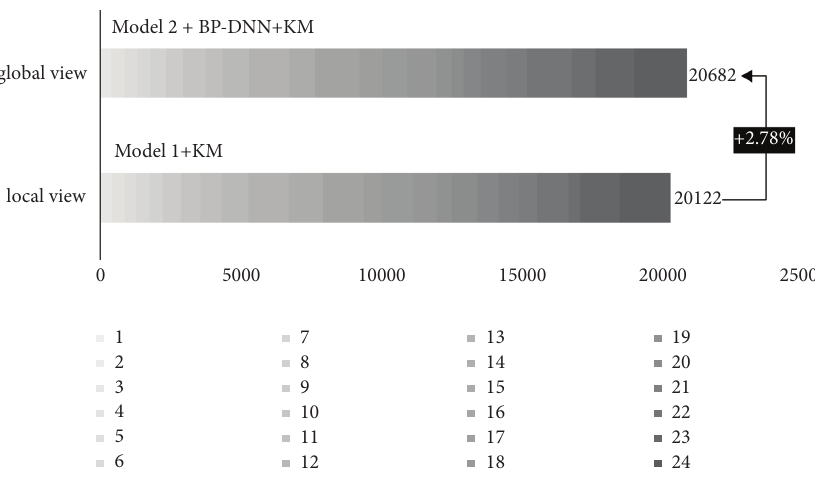
Figure 12: Total revenue comparison of global view and local